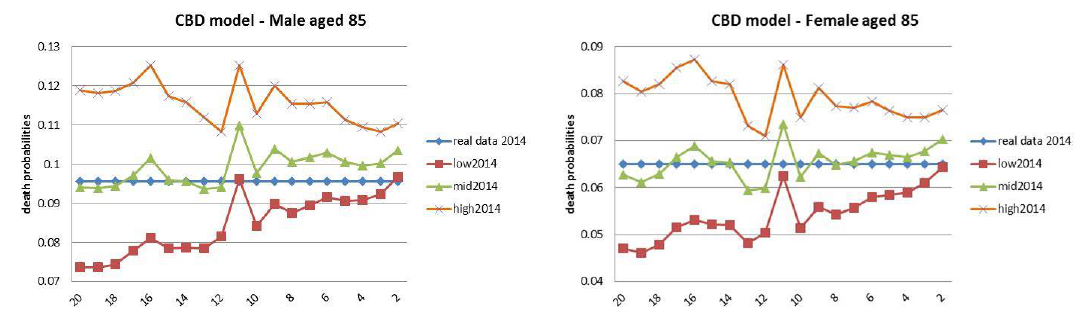
Figure 18. CBD Rolling Fixed-Length Horizon Backtests (age 85): convergence to real data (2014).